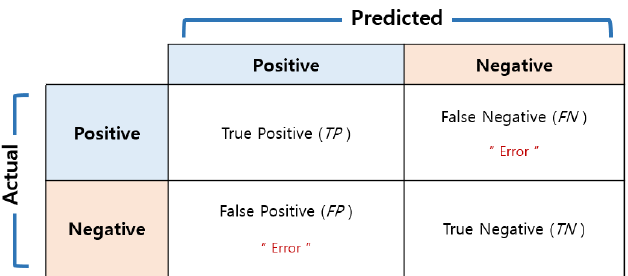
Figure 22. Performance metrics for